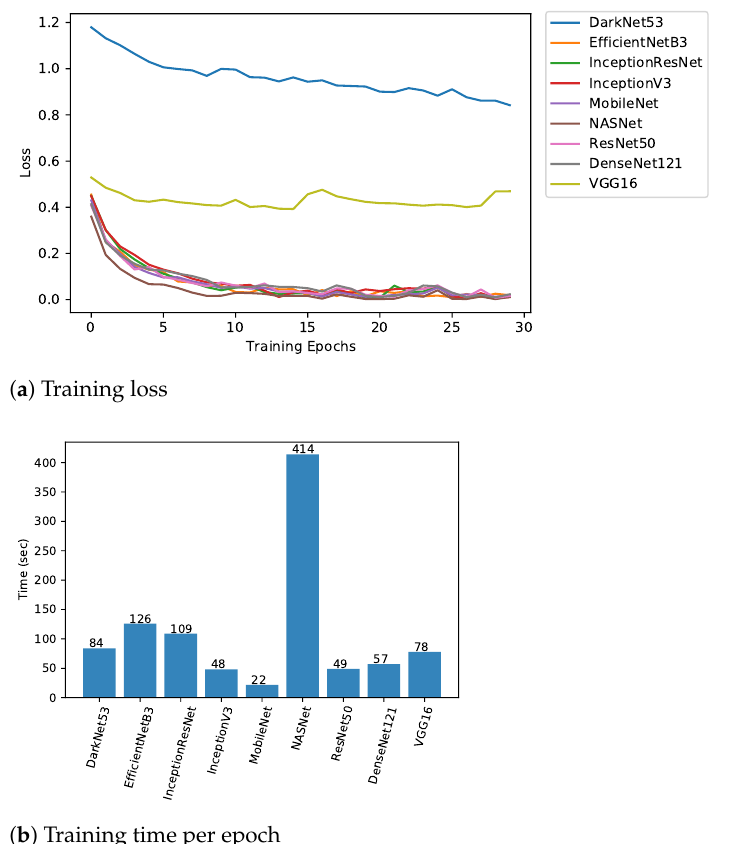
Figure 4. Training performance of implemented CNN models for culvert visual blockage